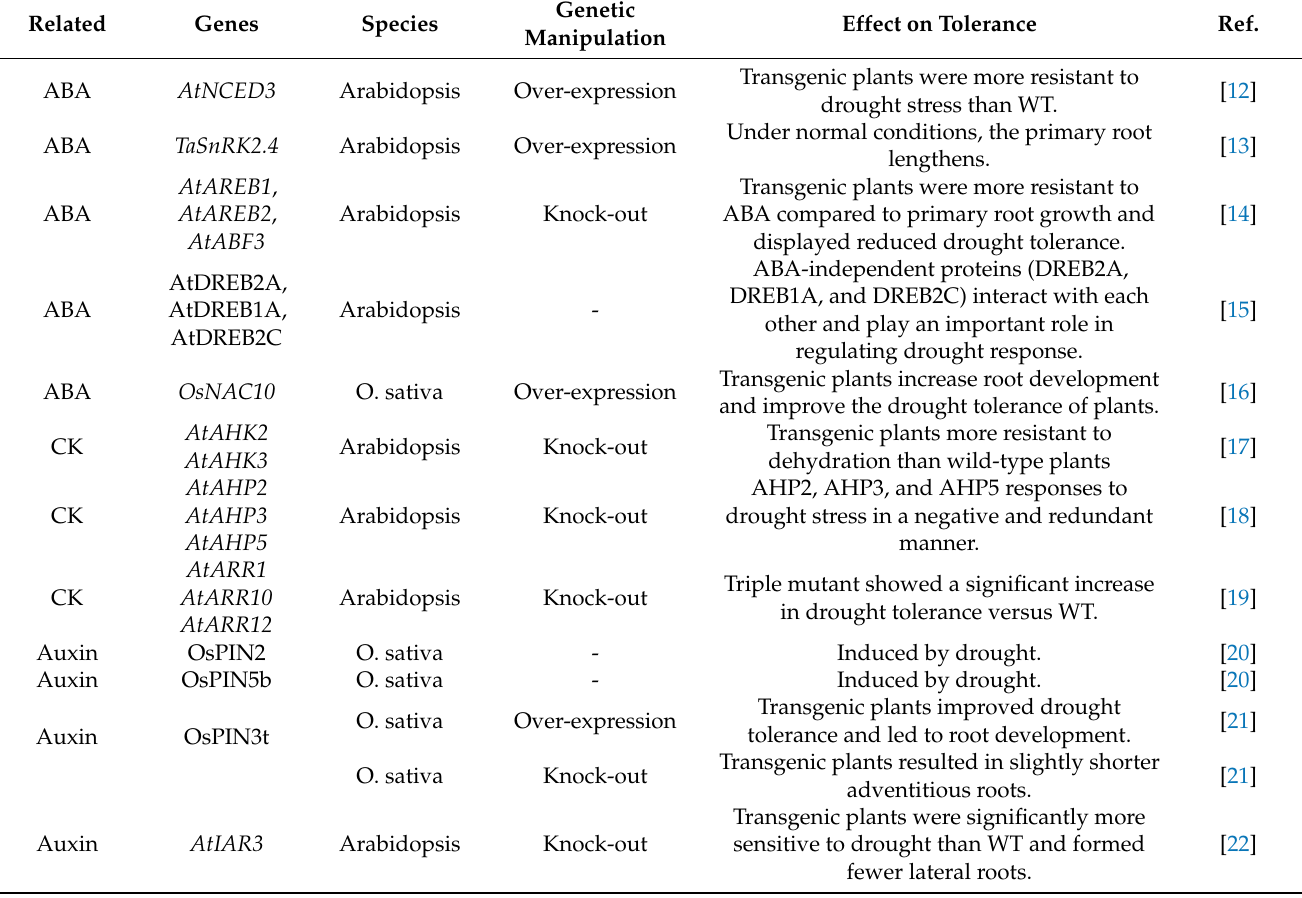
Table 1. Contribution of phytohormones-responsive genes to drought tolerance in